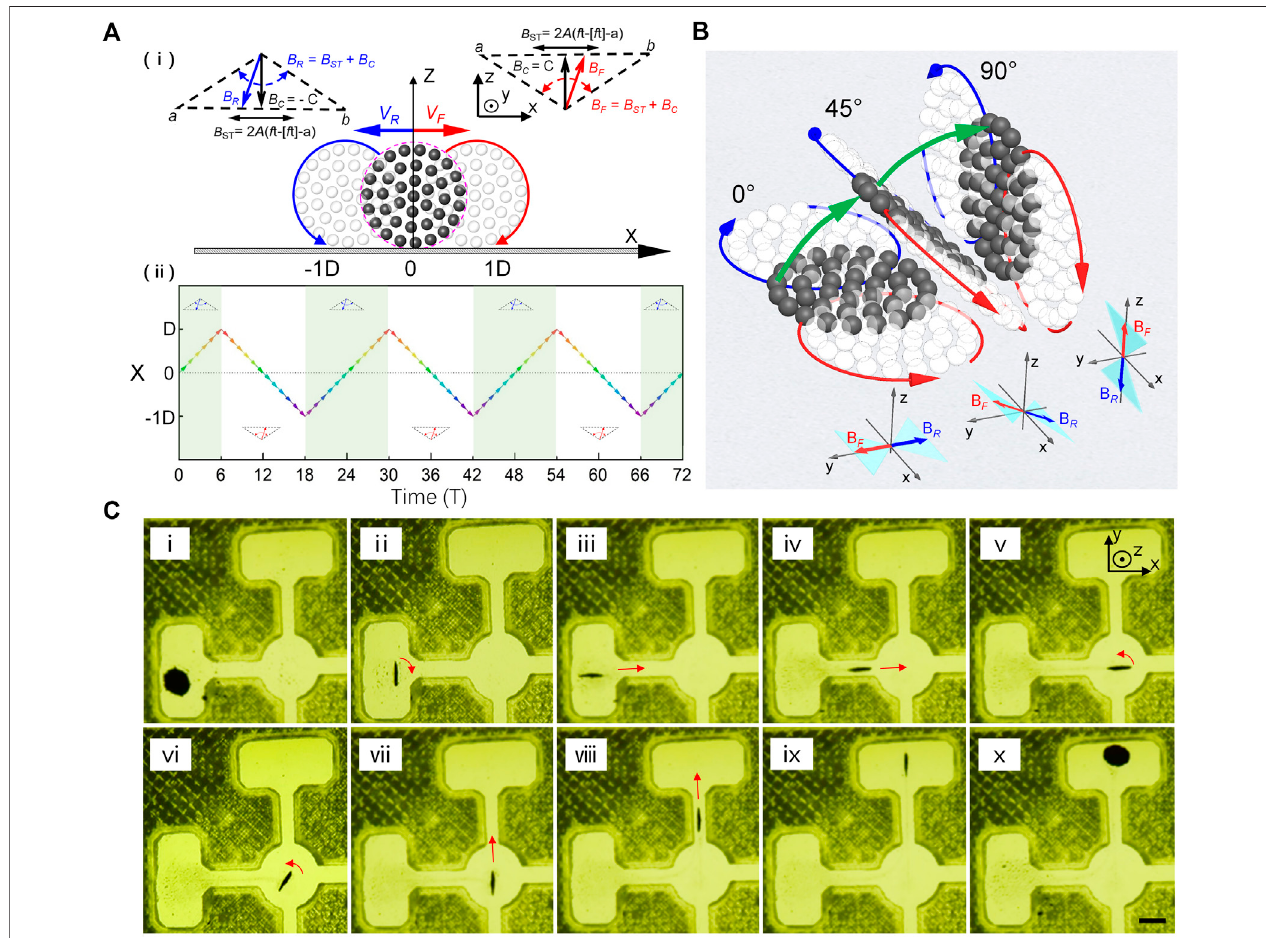
FIGURE 4 | Hovering and erect in situ of wheel-like swarms. (A) Schematic of hovering principle of a vertical swarm by programming swing magnetic fi elds. (i) shows theactuation strategyofhoveringwheel-like swarms. Theswarm rollsclockwiseat speed V F under theaction ofaswingmagnetic fi eld B F (in red). Otherwise,the swarm undergoes an anti-clockwise rolling motion at speed V R , while experiencing a swing fi eld B R (in blue) with reversed constant fi eld B C . (ii) shows time evolution of X-directional displacement of a hovering swarm under alternation of swing fi elds B F and B R . (B) Schematic illustration of in situ standing-up process of a horizontal swarm.Thegreenarrowsindicatethe fl ipmotionofdynamicswarmactuatedbyprogramming “ butter fl y ” swing fi elds. (C) Demonstrationsofsteeringawheel-likeswarm to pass through compact cross-shaped narrow channel. (i) shows the initial state of a static swarm lying horizontal on the substrate. (ii) shows the hovering state of a dynamic wheel-like swarm after in situ standing-up operation. (iii-iv) show the vertical swarm rolls across a narrow channel after an in-situ 90-degree turn in the source rectangle cell. (v-vii) show the in-situ 90-degree turning process of wheel-like swarm in the center circle cell. (viii-x) show the vertical swarm passes through the cross channel and falls down in the destination cell. The scale bar is 1 mm.